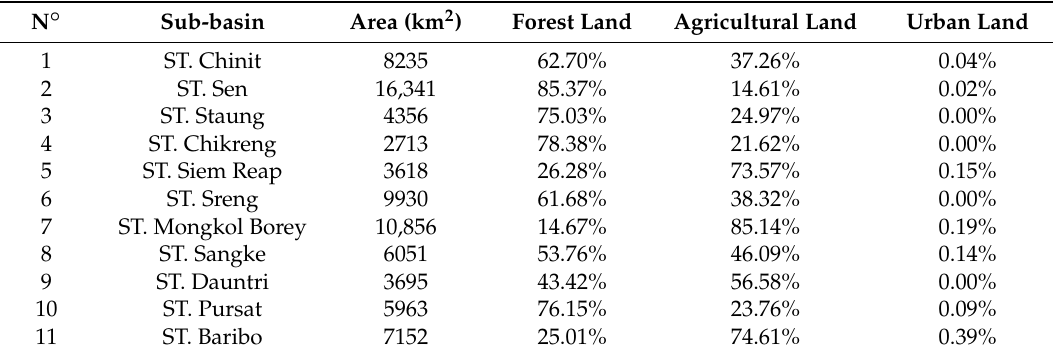
Table 1. Sub-basin areas, land-use, and mean annual flows to the Tonle